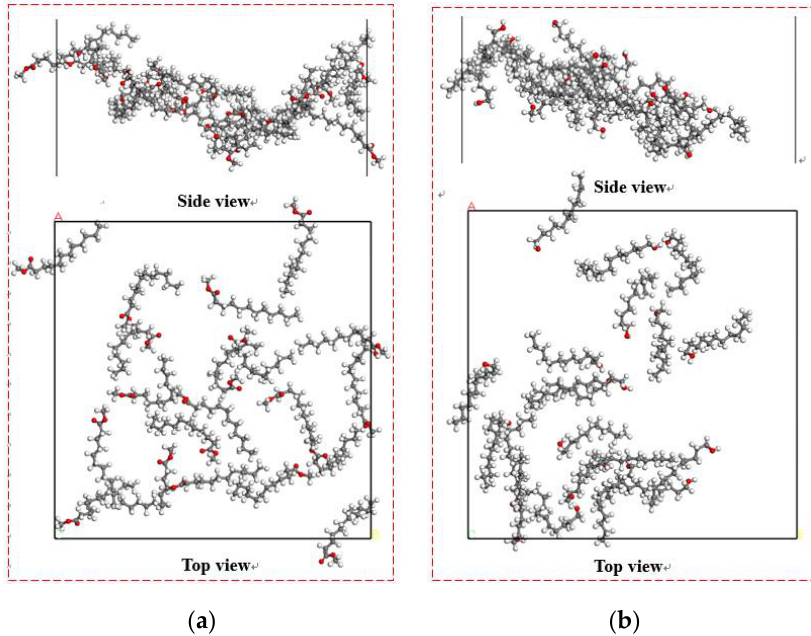
Figure 9. The spatial equilibrium structures of collectors adsorbed on Bulianta coal. ( a ) Methyl laurate; ( b ) dodecanol.